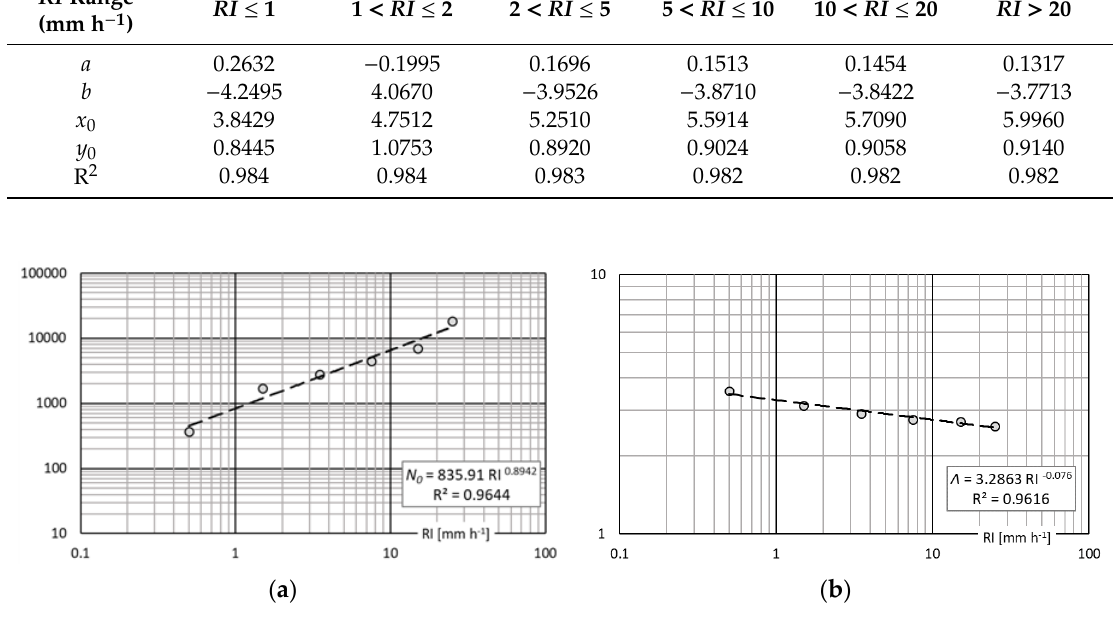
Figure 6. MP parameters associated with the mean values of each RI class (circles) and fitted by power law curves (dashed lines), ( a ) intercept 𝑁 0 and ( b ) exponent Λ .